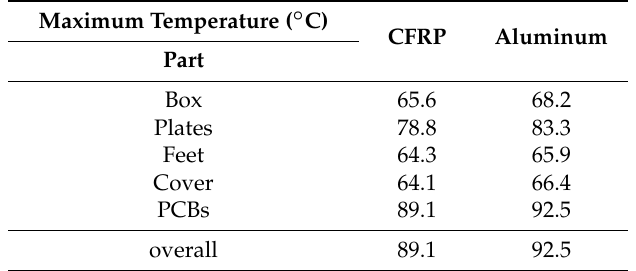
Table 19. Maximum temperature for CFRP and aluminum box concepts.